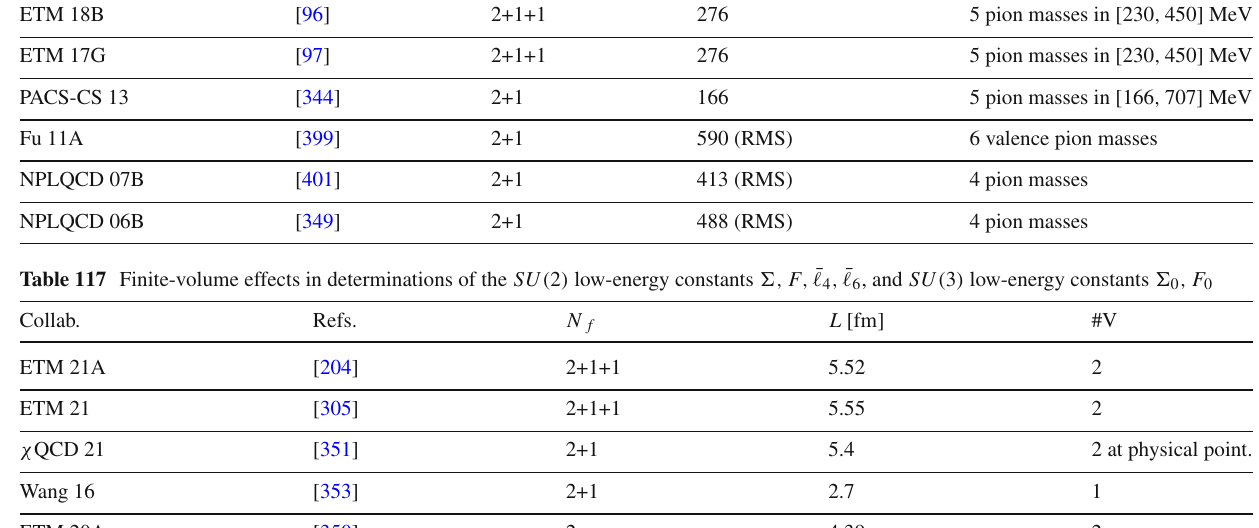
Table 116 Chiral extrapolation/minimum pion mass in determinations of the low-energy constants related to π K scattering Collab.